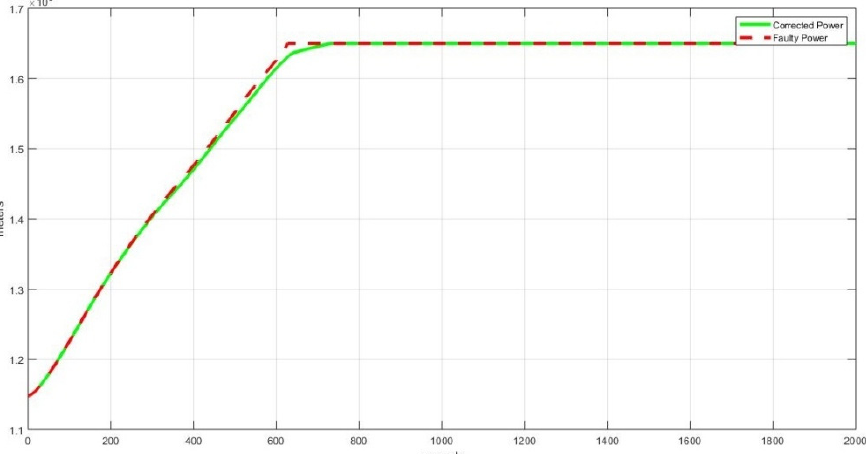
𝑤 (cid:2869) leakage fault.